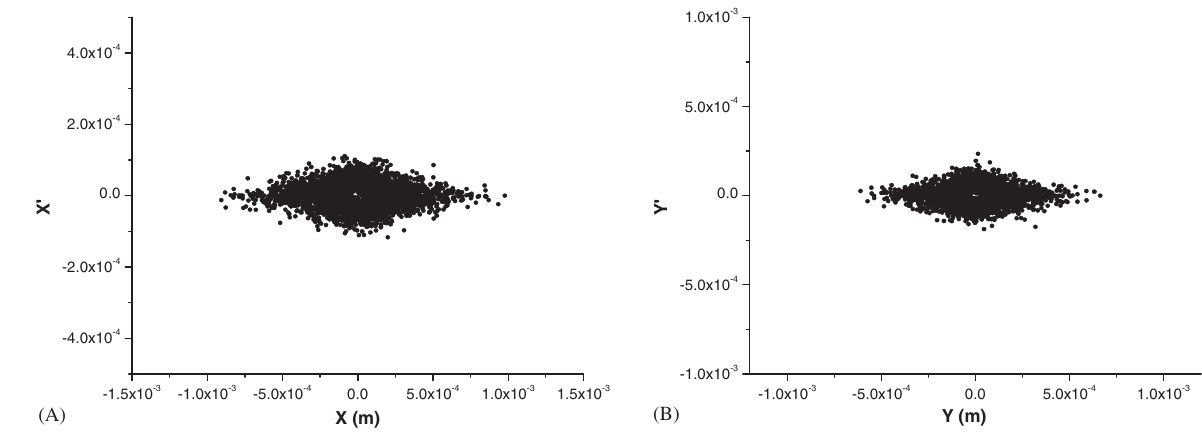
FIG. 10. Initial beam distribution in horizontal and vertical phase